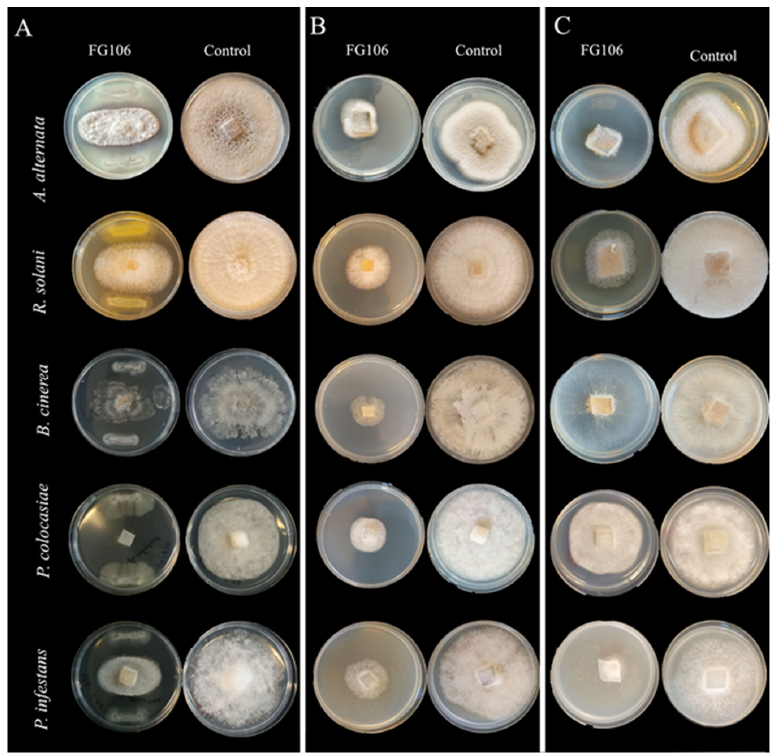
Figure 1. Determination of in vitro antagonistic activity of Pseudomonas aeruginosa strain FG106 against selected phytopathogens. ( A ) Antagonistic potential of FG106 strain in dual culture tests. ( B ) Antimicrobial effects of non-volatile metabolites produced by strain FG106. ( C ) Inhibitory effect of volatile metabolites produced by strain FG106.